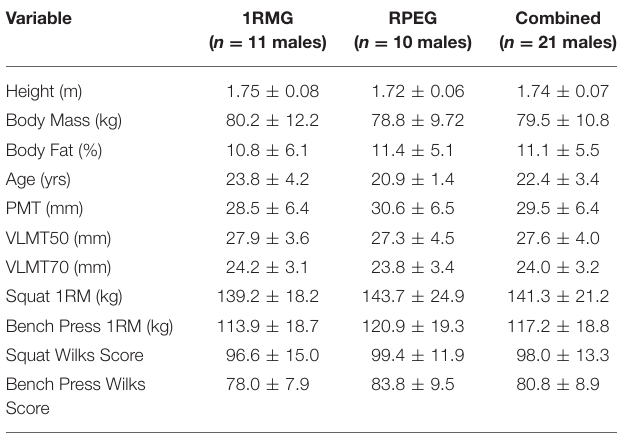
1RMG,percentage1RMloadgroup;RPEG,RPEloadgroup.Valuesaremean ± standard deviation. 1RM, one repetition maximum; PMT, pectoralis major muscle thickness; VLMT50, vastus lateralis muscle thickness at 50% femur length; VLMT70, vastus lateralis musclethicknessat50%femurlength.Combined,meanvaluesofall21participants.Wilks